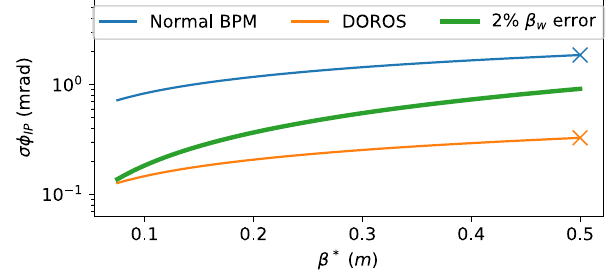
FIG. 11. Expected measurement error of the standard and DOROS BPM systems taking as reference a measurement at 50 cm β (cid:1) . The green line shows the required phase measurement error to achieve a 2% error in β w .